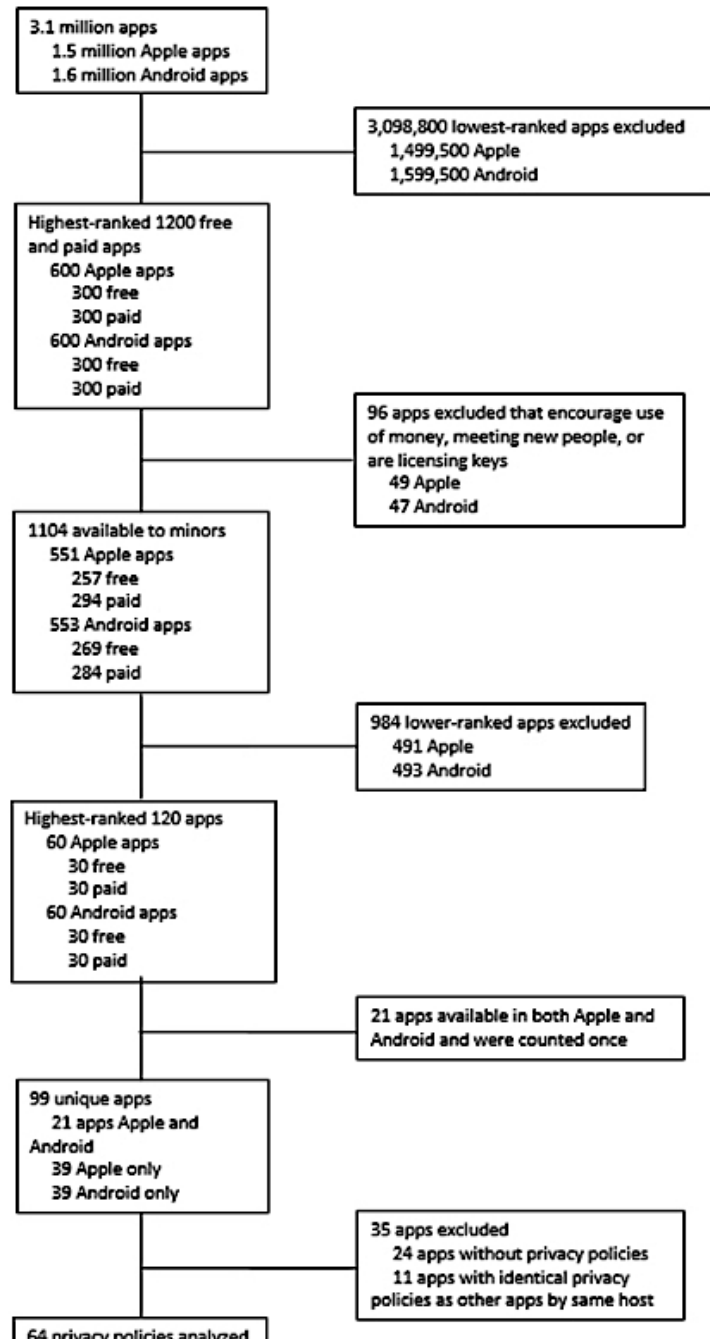
Figure 1. App selection process flowchart (completed March